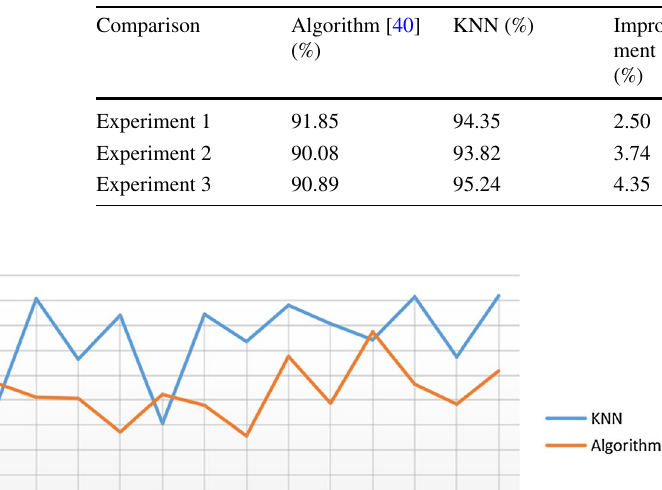
Table 8 The comparison result on three groups experiments about average